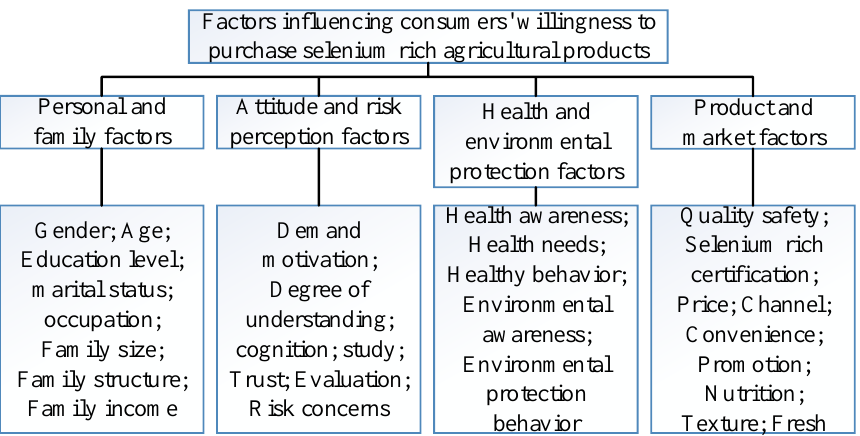
Figure 7. Factors influencing consumers’ willingness to buy enough organic agricultural products. sists of three parts: (1) How product attributes, product knowledge, shopping atmosphere, price sensitivity and green awareness affect consumers’ purchase attitude towards green agricultural products; (2) How purchasing attitude affects consumers’ willingness to buy green agricultural products; (3) The moderating effect of purchase channels on product attributes, product knowledge, shopping atmosphere, price sensitivity, green awareness and consumers’ attitudes towards purchasing green agricultural products, among which purchase channels mainly select supermarkets and farmers’ markets where consumers choose to purchase green agricultural products more frequently for comparative research.